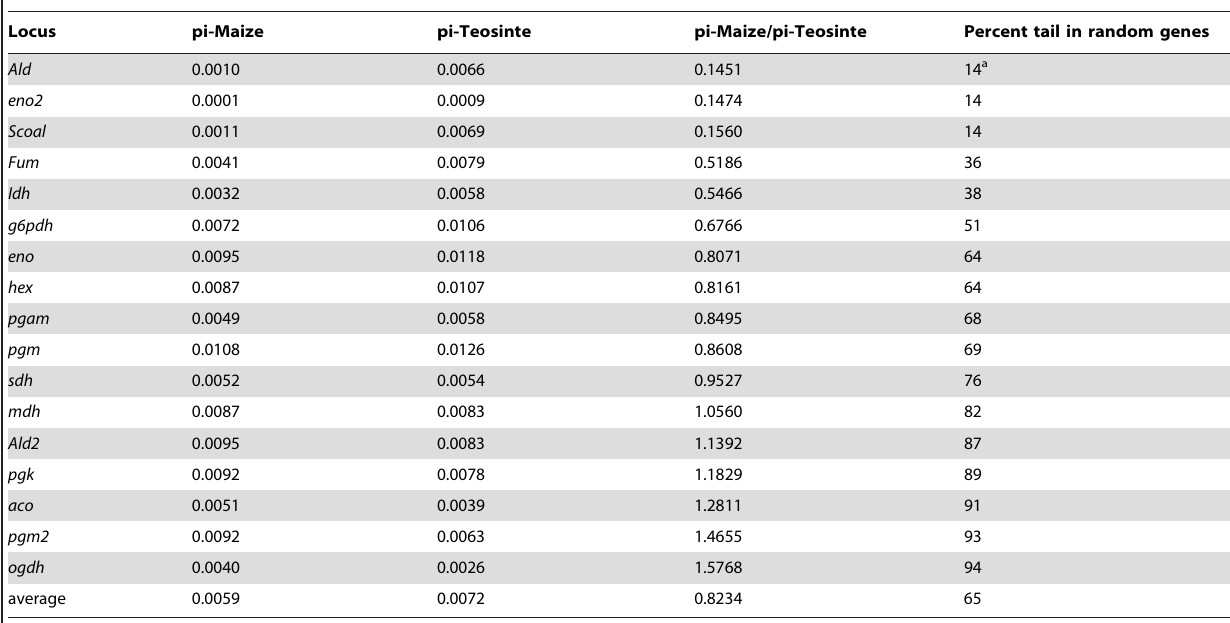
Table 6. CCM gene diversity in maize and teosinte.